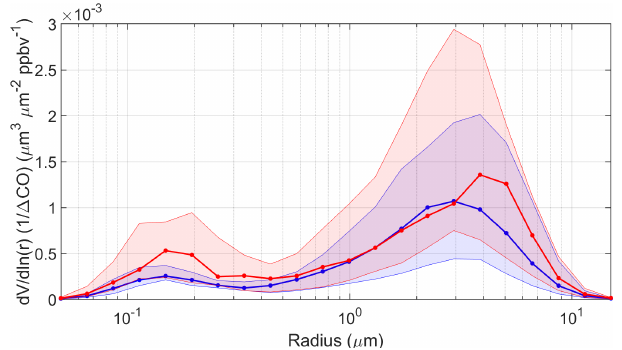
Figure 8. Volume size distributions (VSDs) normalized by (cid:49) CO for high-APT ( > 13mm; blue, n = 16) and low-APT ( < 0.9mm; red, n = 19) groups for Cluster 1 trajectories. Thick curves correspond to medians, and shaded areas extend to the 25th and 75th percentiles. VSDs are based on AERONET data between 1 January 2015 and 31 December